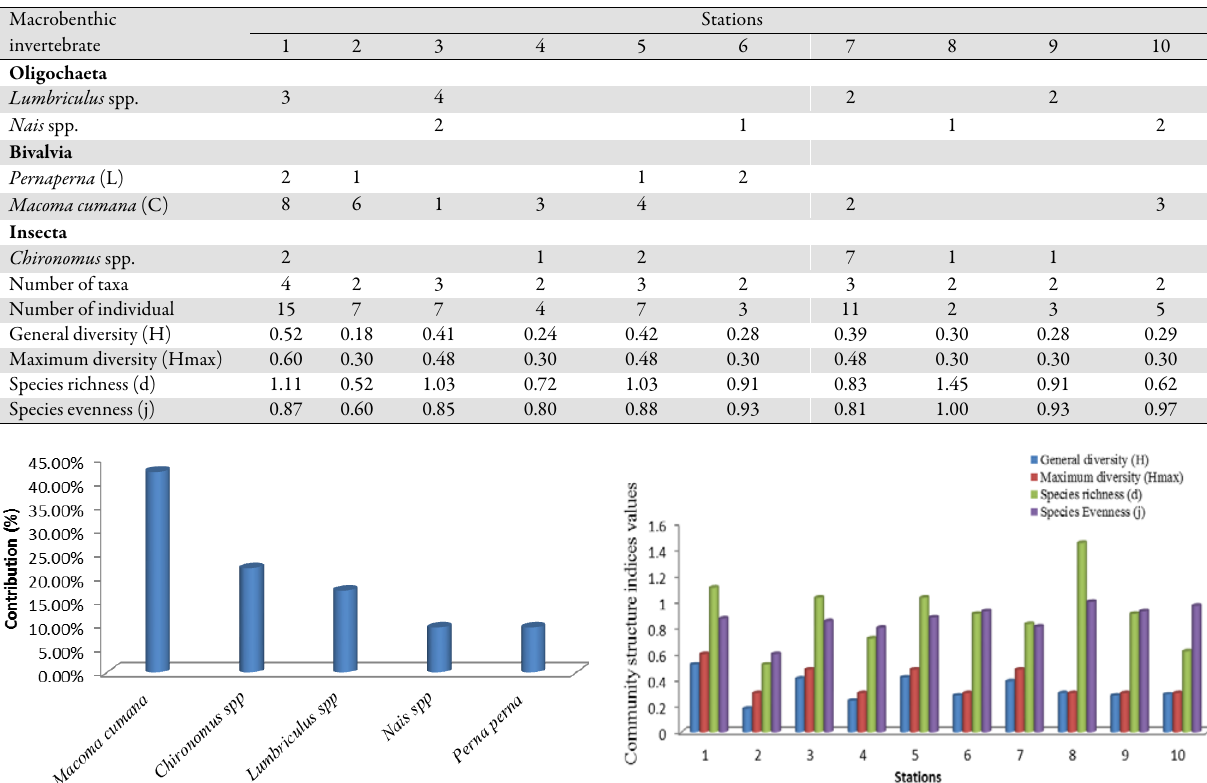
Fig. 4. Comparison of macrobenthic invertebrate community structure indices at Oluwa and Ifara Rivers, Ondo State Table 6. The distribution, occurrence and diversity indices of macrobenthic invertebrate community at Ibefun River study stations